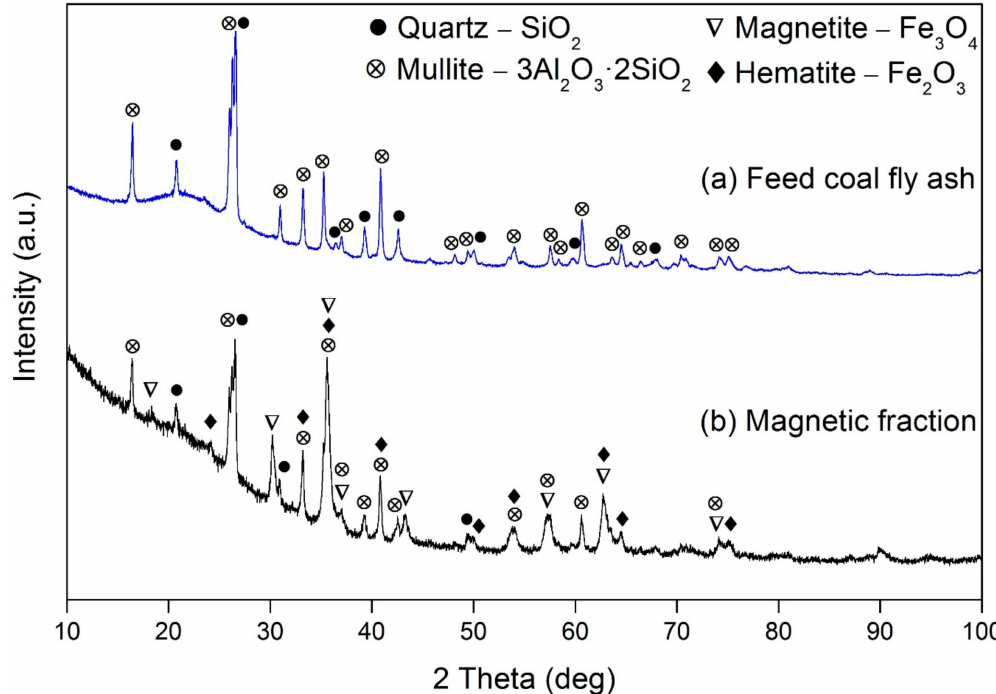
Figure 1. XRD patterns of coal fly ash from Ekibastuz’s SDPS-1, the Republic of Kazakhstan: ( a ) feed ash; ( b ) magnetic fraction of